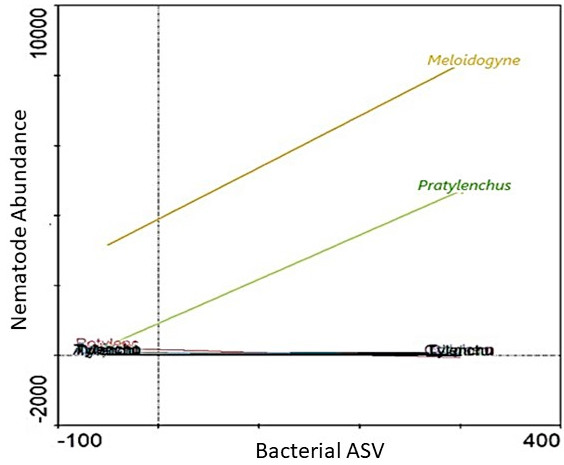
Figure 8. A functional response graph showing the correlation between the abundance (Bacterial ASV) of the genus Ambiguous_taxa16 and the abundance of Meloidogyne (orange line) and Pratylenchus (green line) that were extracted from soybean roots sampled from the Highveld production area in the Mpumalanga province, South Africa.